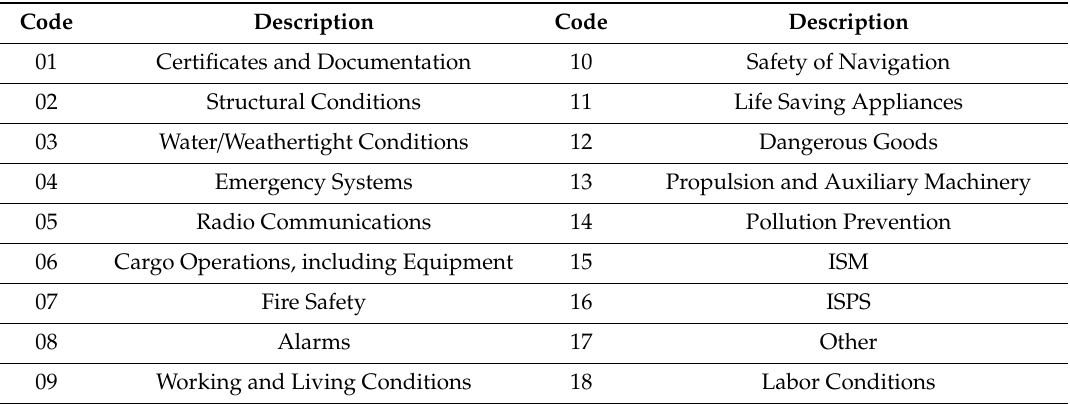
Table 2. Main items of deficiency codes in the 2017 Tokyo memorandum of understanding (MOU) [27].